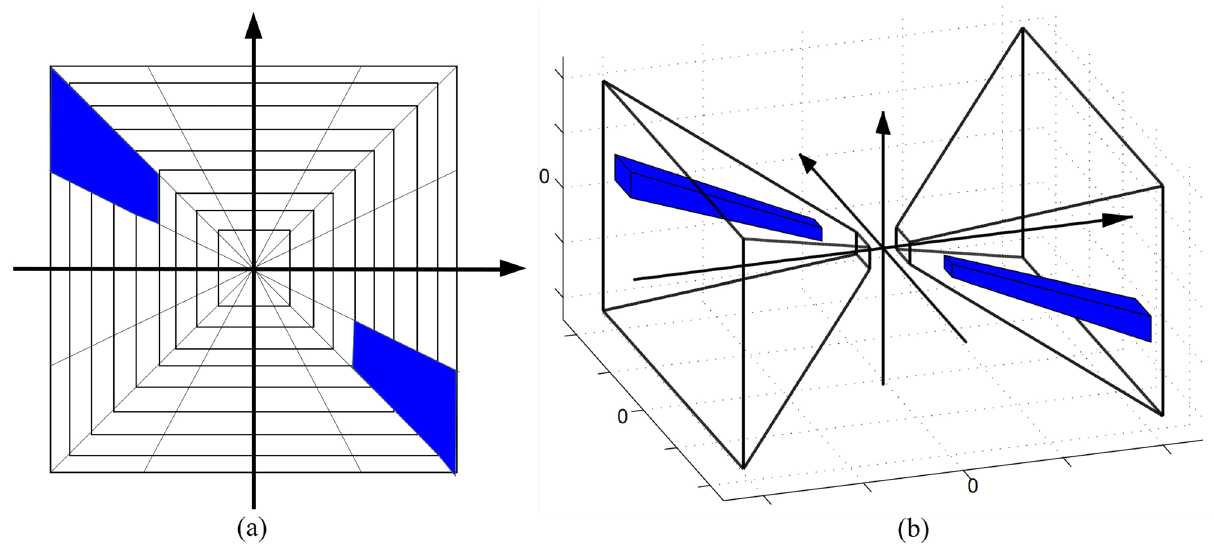
Figure 3. The difference between the 2D and 3D shearlets. ( a ) A representative shearlet function for 2D transformation. ( b ) A representative shearlet function for 3D transformation.